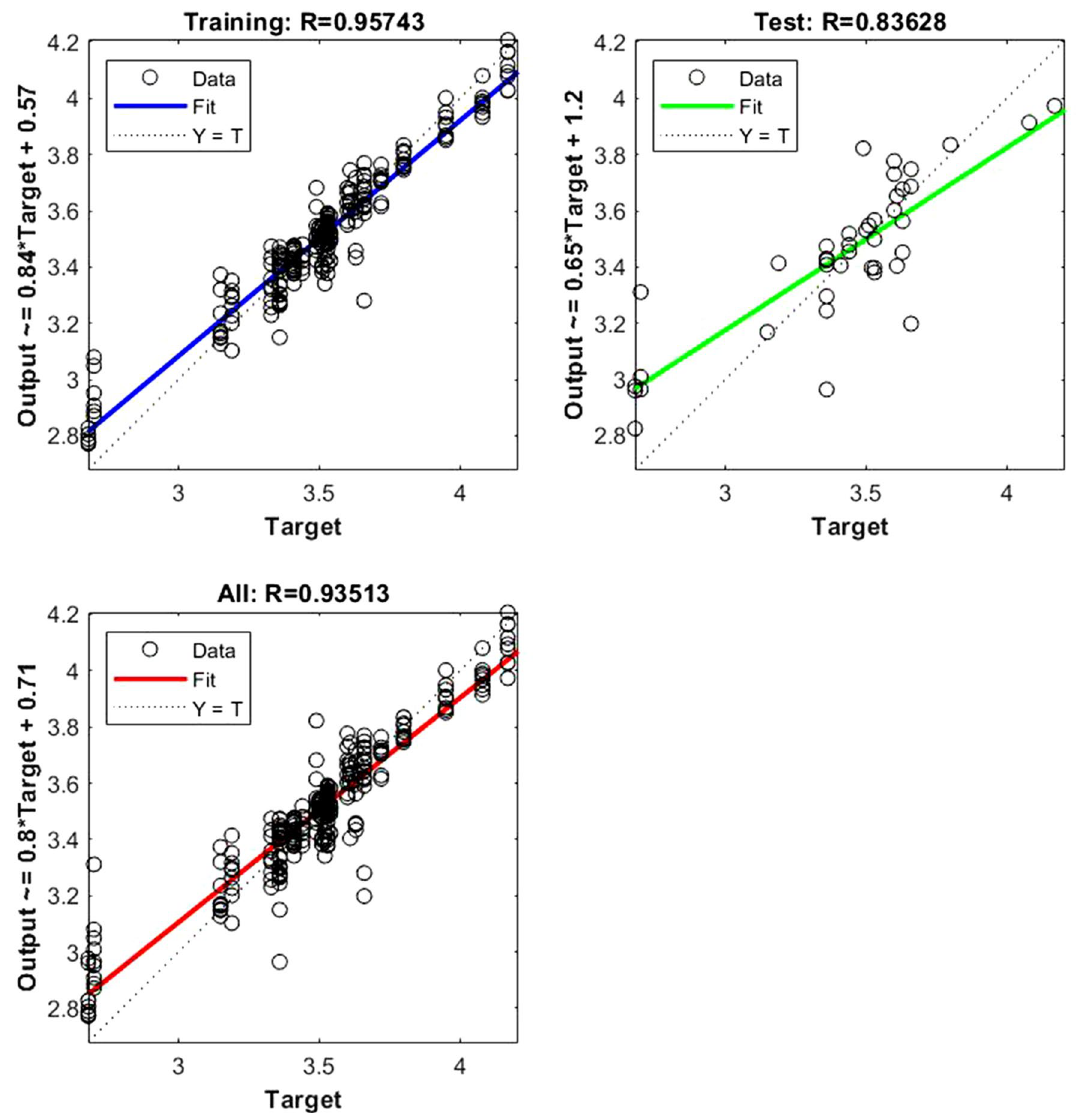
R test = 0.83, the number of spectra used for training was N = 270). The RBC concentration in patients’ blood was 3.49 ± 0.309·10 12 l (mean ± SD). The R all represents the value of R for the training and test sets. The equation relating the predicted and measured values is Output = 0.8*Target +